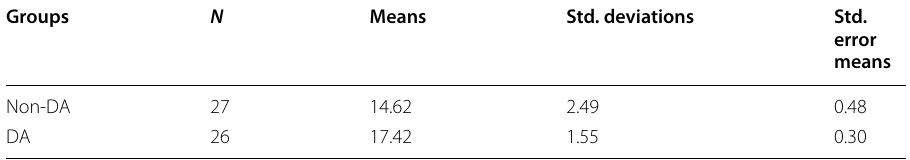
Table 8 Descriptive statistics (writing posttest of both groups) Groups N Means Std. deviations